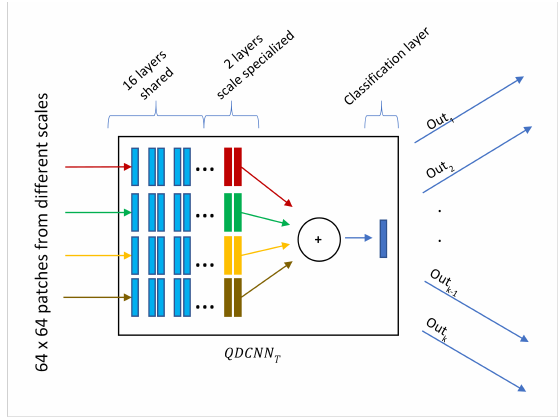
Figure 5. The QDCNN structure is composed of 4 DCNNs with a joint classification layer and a joint loss. The number of outputs k is 8 for transverse and 4 for sagittal